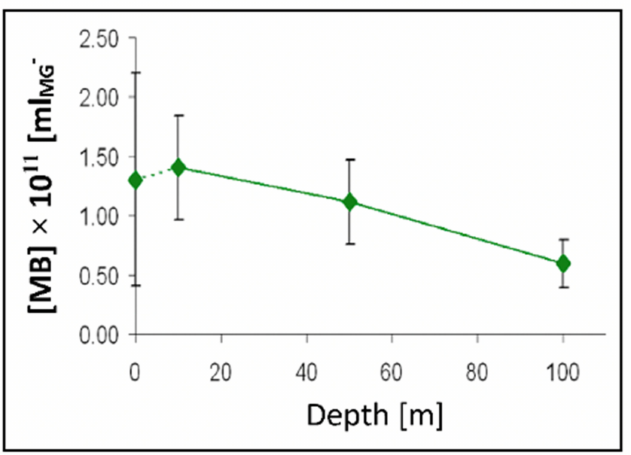
Figure 26. The concentration of [MB] MG lodged inside MG ranged from 0.6 to 1.4 × 10 11 MB × mL − 1 SW. It is more than five orders of magnitude higher than the concentration of free [MB] in SW. Points are the average ± SD. of 72 sections in 12 microgels collected in each of two samples per